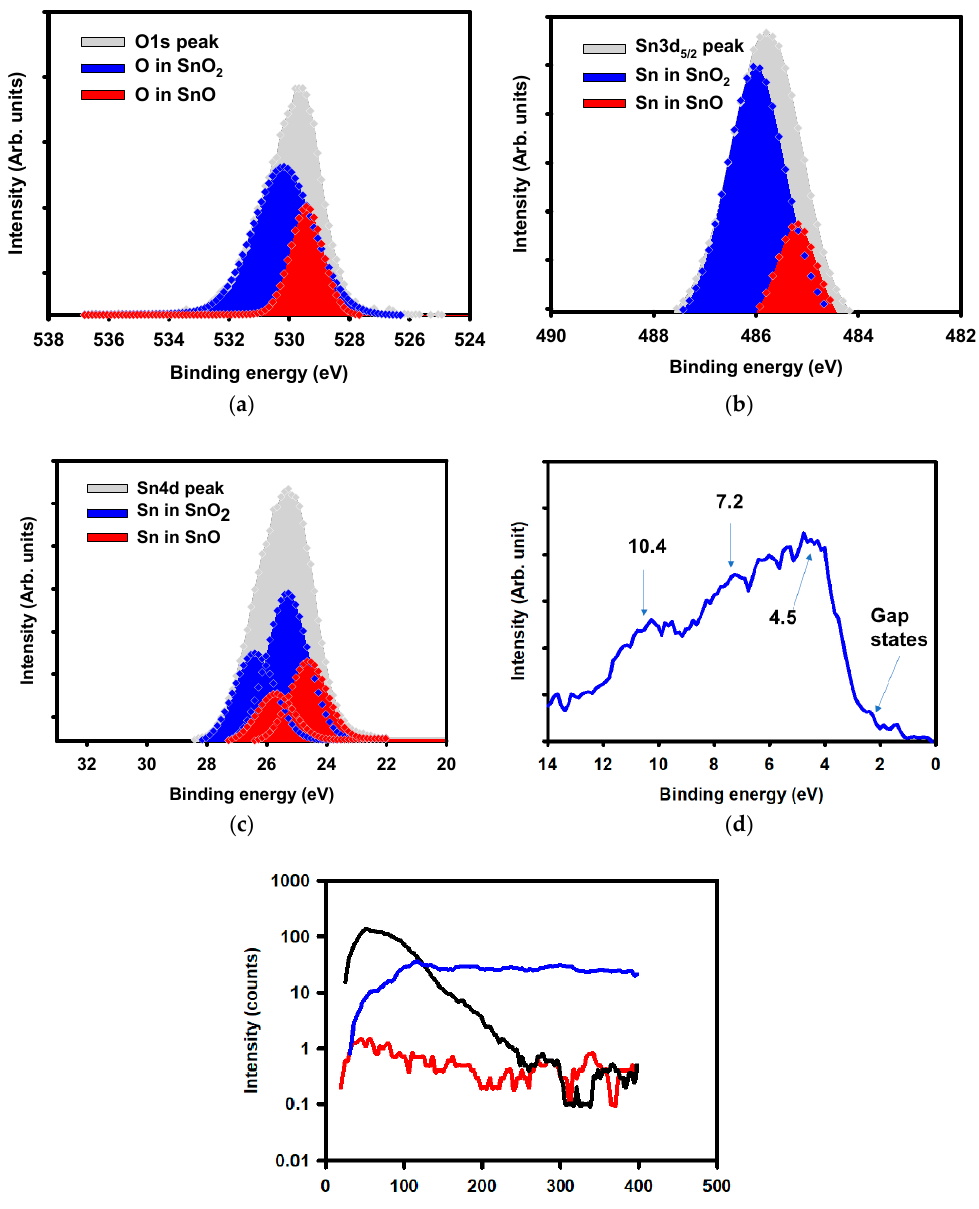
Figure 2. Composition analysis of a-SnO x . ( a ) O1s spectrum and decomposed components of a-SnO x thin film. The blue part represents oxygen in SnO 2 , the red one oxygen in SnO. ( b ) Deconvolution of the Sn3d 5/2 peak. The blue part represents Sn as in SnO 2 , the red part Sn as in SnO. ( c ) Sn4d peak analysis. The two doublets related to SnO 2 are in blue, the doublets related to SnO are in red. ( d ) Valence band analysis of a-SnO x . ( e ) TOF-SIMS profile of a-SnO x . In blue, red, and black are shown CsSi + , CsC + , and CsSn + depth profile, respectively. In the above charts, Arb. stands for